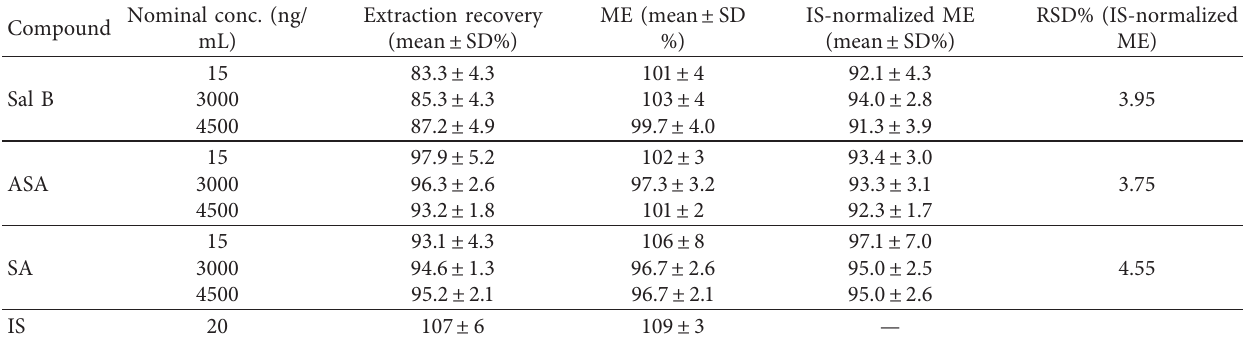
Table 3: Extraction recovery and matrix effects of Sal B, ASA, SA, and IS ( n � 6).